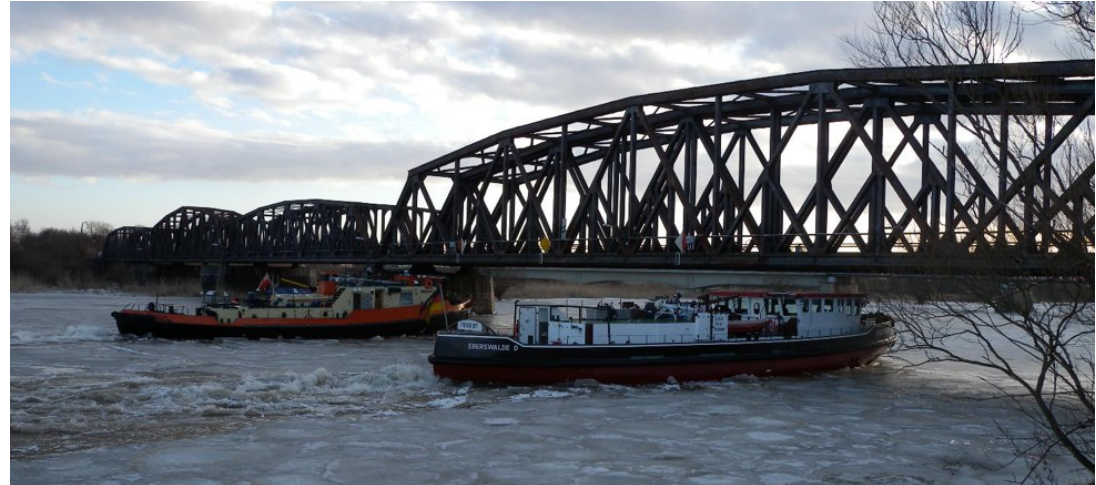
Figure 5. Ice breakers barely able to drive under a bridge during high flows in the Oder River (courtesy of Regional Water Management Authority, Szczecin).